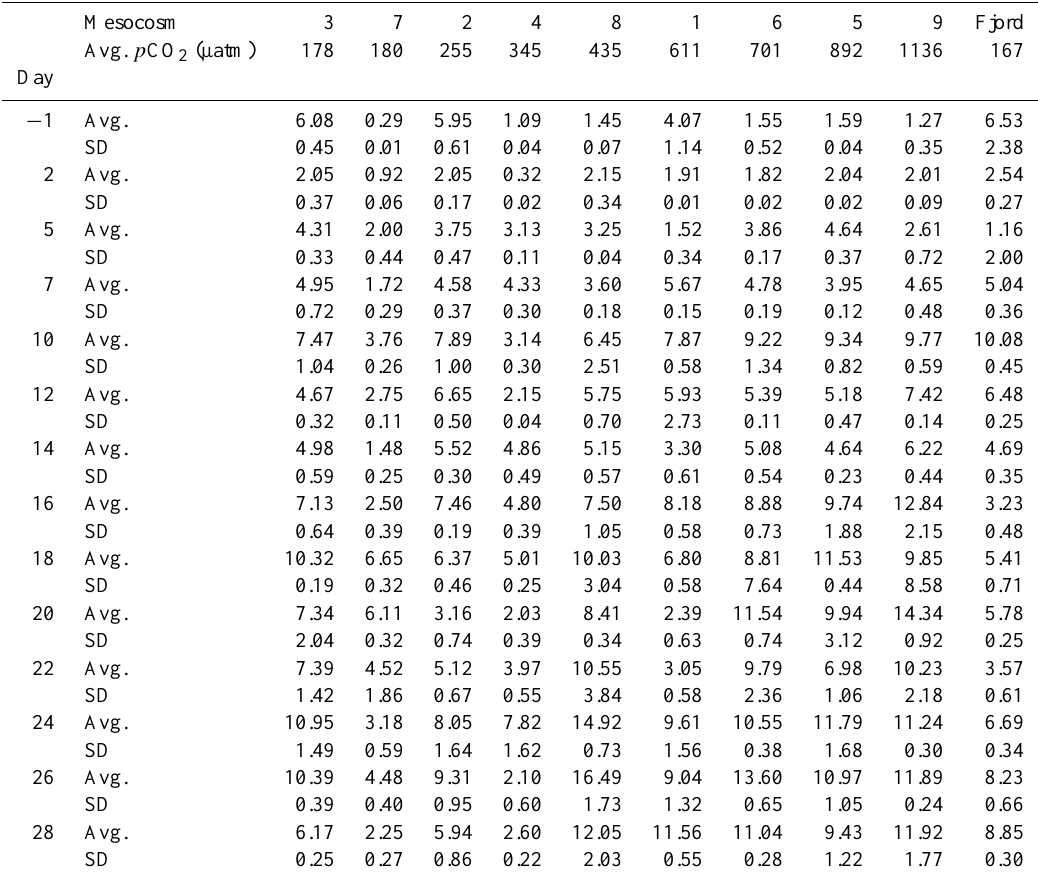
Table 2. Production (µmolL − 1 d − 1 ) of particulate organic carbon (POC), based on 14 C bottle incubations. Averages (Avg.) and standard deviations (SD) were calculated from on triplicate measurements of 24h